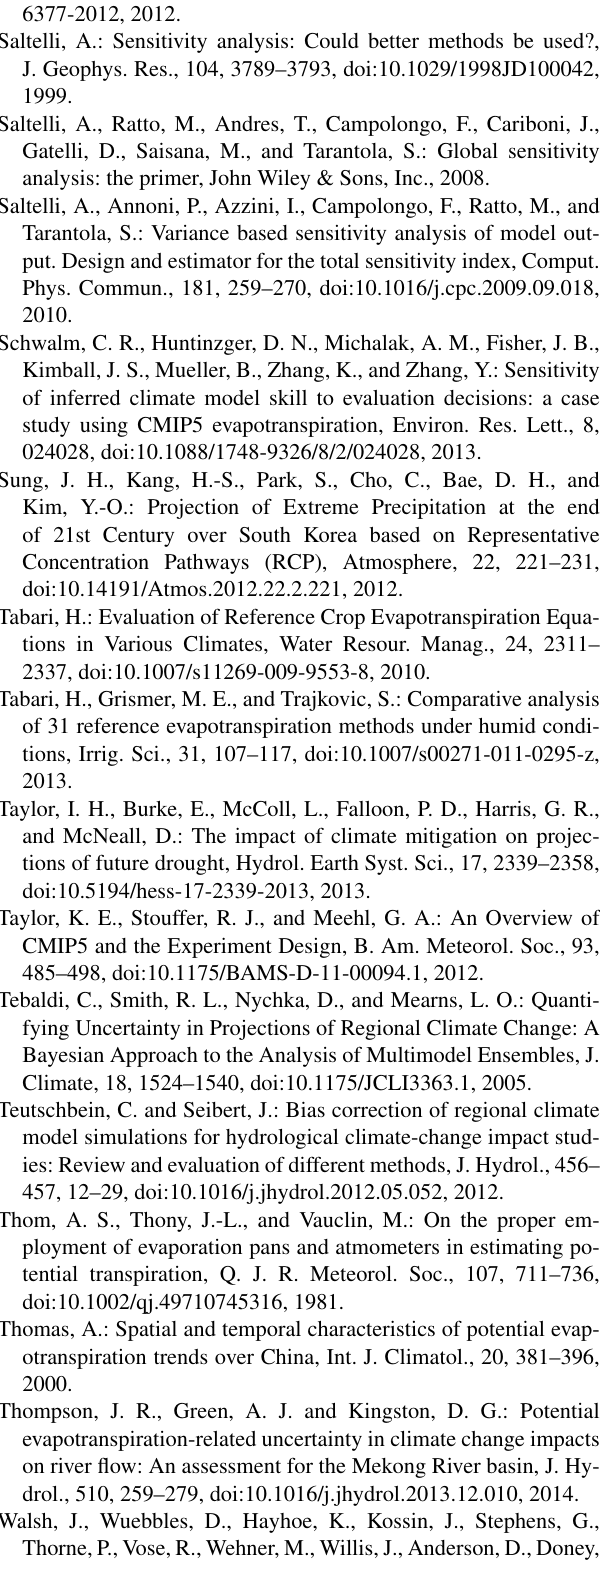
Tabari, H.: Evaluation of Reference Crop Evapotranspiration Equa-